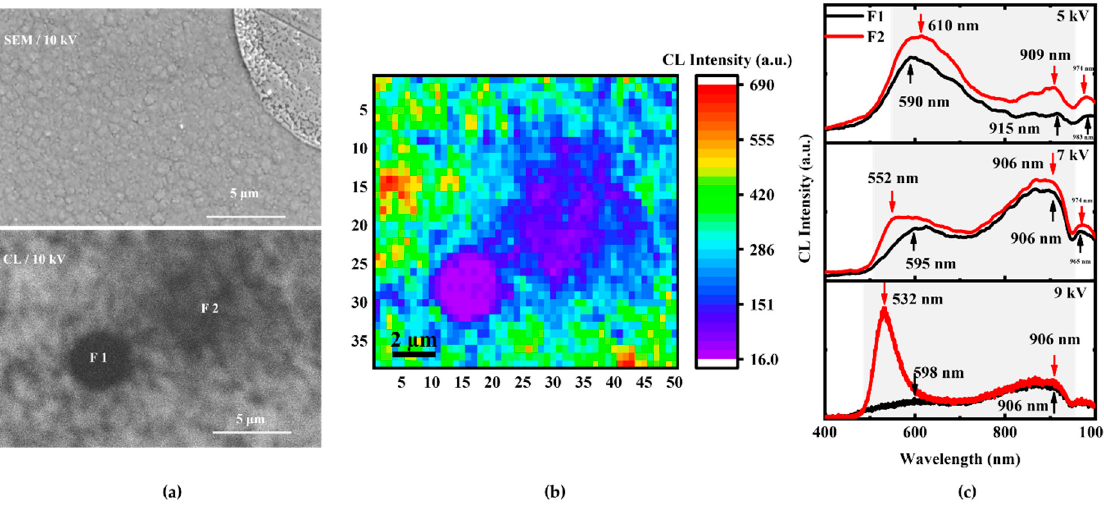
Figure 5. ( a ) SEM and CL images of the paired defects (F1 and F2). ( b ) CL mapping image of the paired defects at 10 kV beam voltages. The scanning area contains 50 × 38 pixels. ( c ) CL spectra of the paired defects at 5 kV, 7 kV, and 9 kV beam voltages. The main CL peaks have been indicated by arrows.